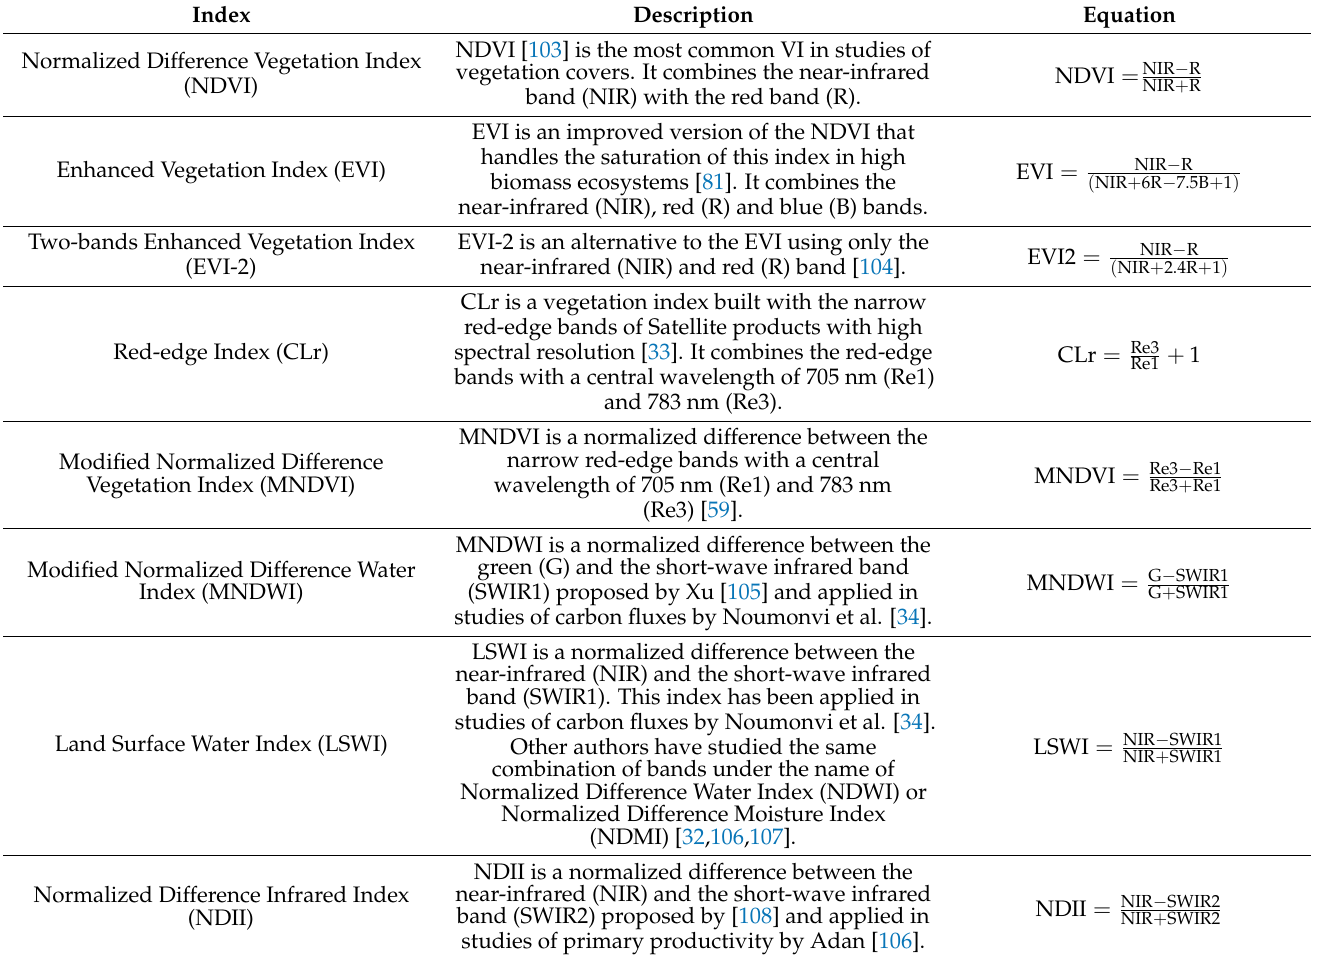
Table A1. Remote sensing based vegetation indexes used in the current